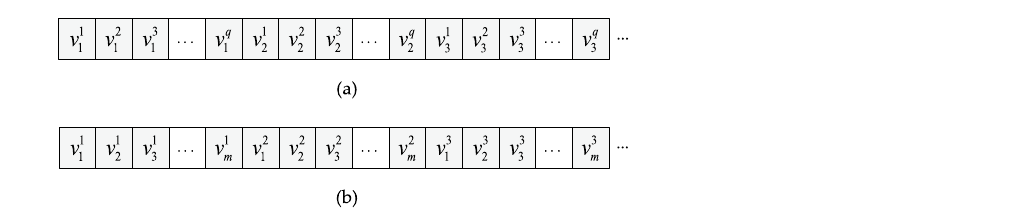
Figure 6. The data sequence of traversal methods. ( a ) The data sequence of TFS; ( b ) the data sequence of